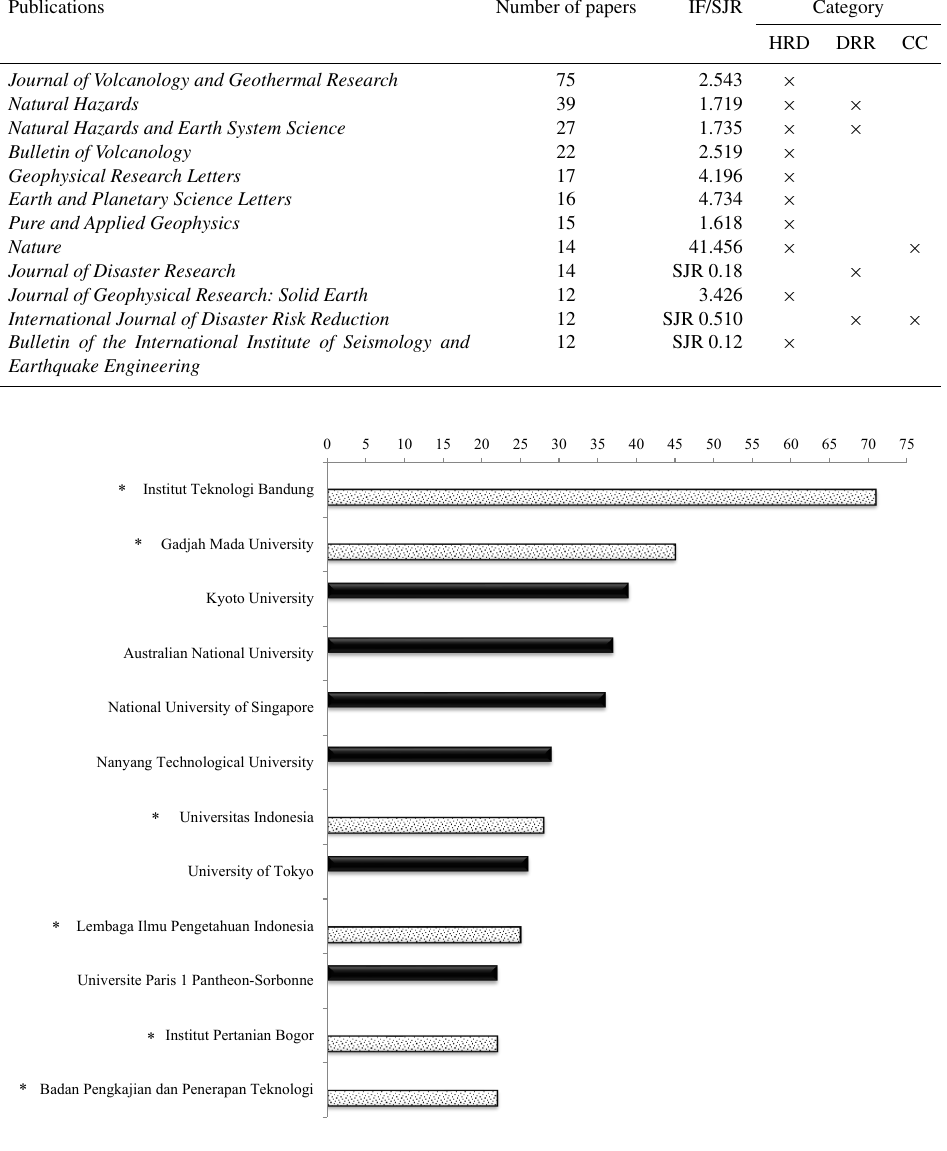
Figure 6. Organizations with the highest number of publications (Indonesian organizations marked with ∗